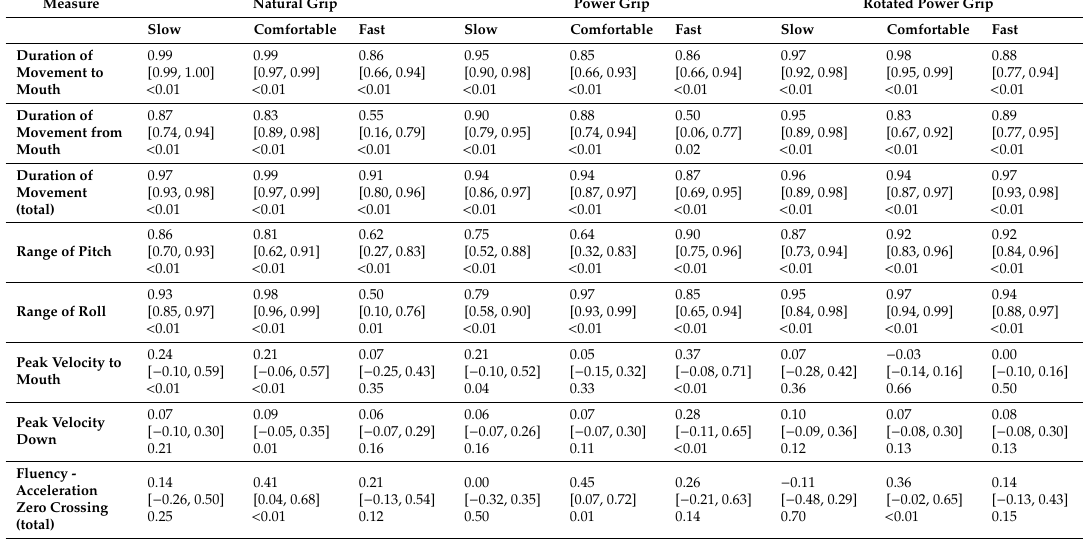
Table 2. Intraclass correlation coe ffi cients (ICCs) depicting agreement between trakSTAR and DataSpoon, with 95% confidence interval (square brackets) and significance level below. ICC values higher than 0.8 (excellent agreement) are in bold.